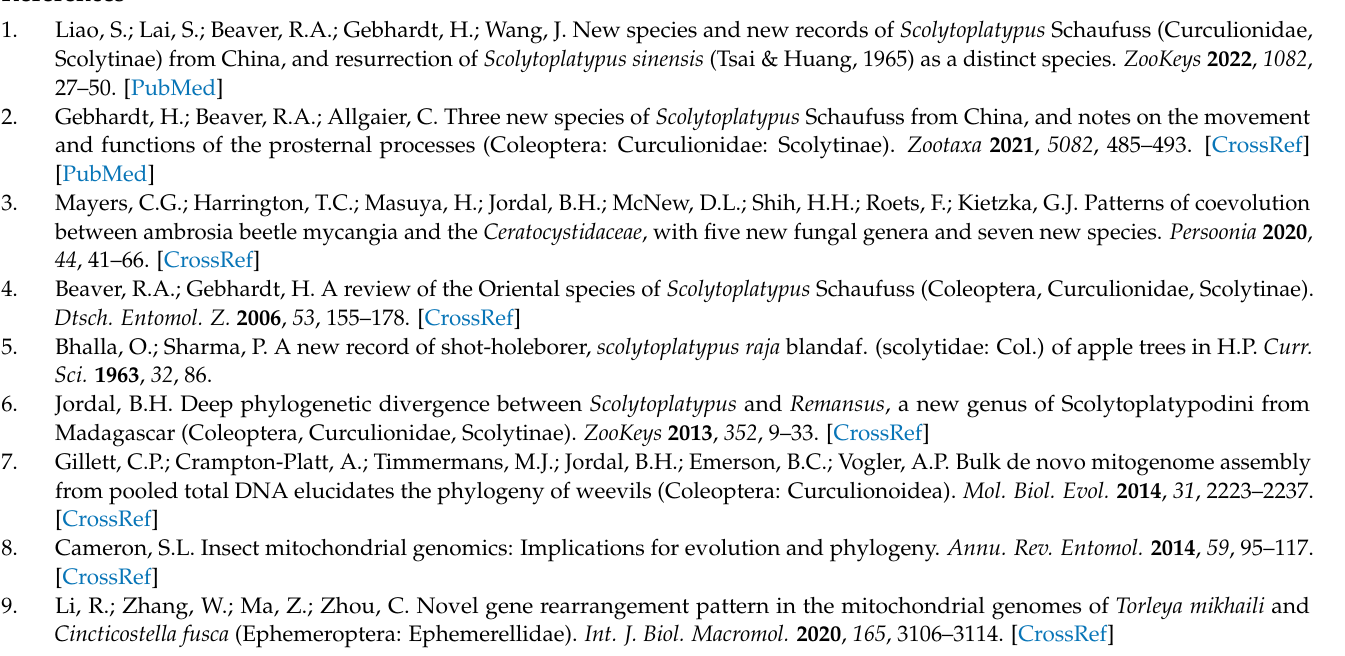
the mtDNA of S. raja ; Figure S2: Secondary structures for tRNA genes from the mtDNA of S. sinensis ; Figure S3: Secondary structures for tRNA genes from the mtDNA of S. skyliuae ; Figure S4: Secondary structures for tRNA genes from the mtDNA of S. wugongshanensis ; Figure S5: Phylogenetic tree of Scolytinae using the BI method based on 13 PCGs. Table S1: The best-fit partitioning scheme and corresponding models used on the phylogenetic tree; Table S2: Nucleotide compositions in regions of the S. raja , S. sinensis , S. skyliuae , and S. wugongshanensis mitochondrial genomes; Table S3: